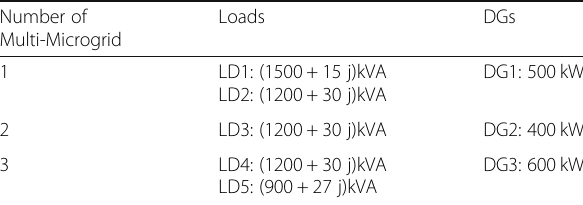
Table 3 Capacity of DGs and loads in the multi-microgrid Number of Multi-Microgrid